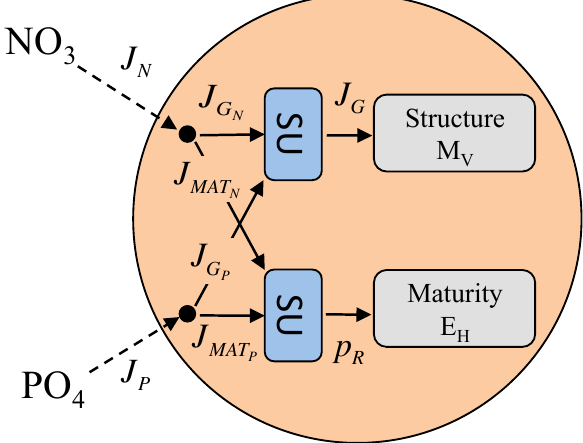
Figure 9. Simple physiological model of a dividing phytoplankton cell that reproduces the covariation of metabolic rates and cell size observed in coccolithophores. Notes: J X – assimilation fluxes; J